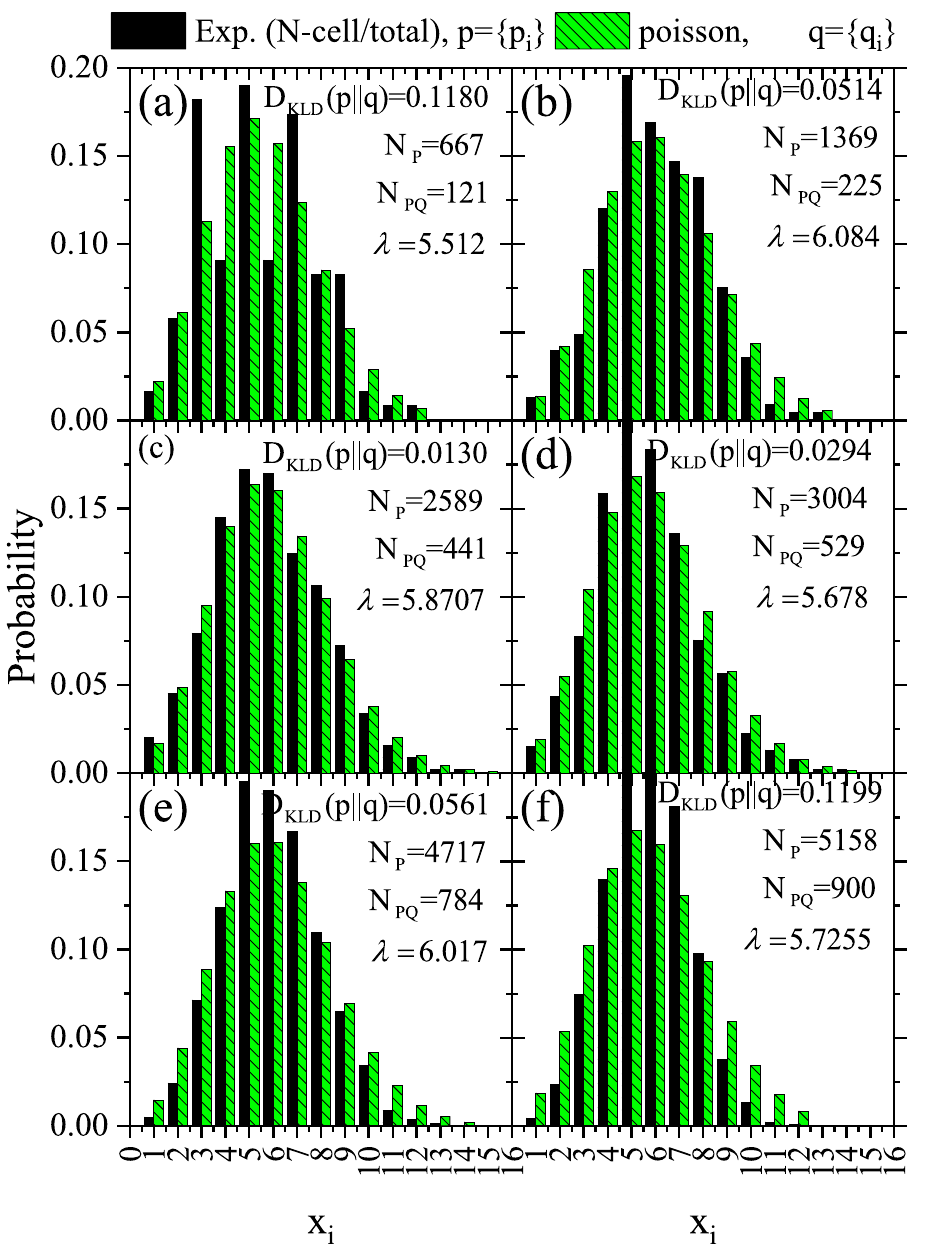
Figure 9. Probability histogram for the test hypothesis p for samples a4, b4/1, c4, d4/1, e4, and f4 versus the null hypothesis q versus the number of features x i within each quadrate. They were constructed as in Fig.